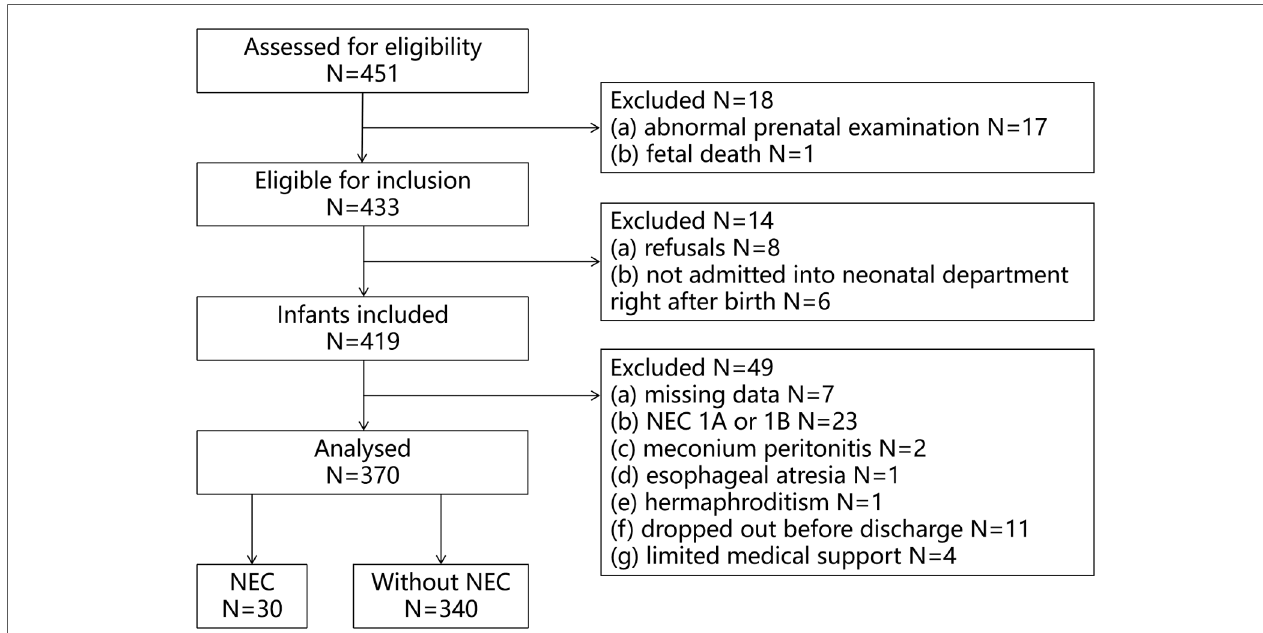
FIGURE 1 Flowchart of the